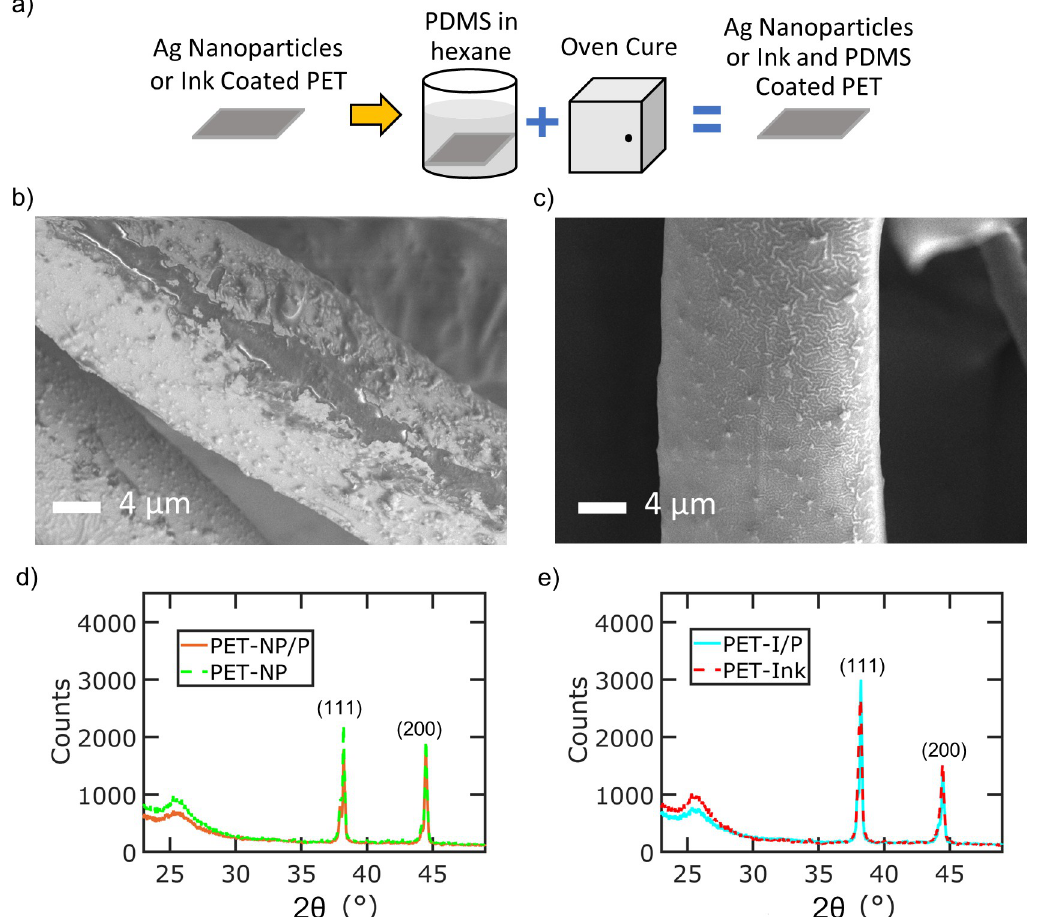
Fig 3. Characterization of samples with PDMS. a) Schematic of PDMS treatment for silver coated PET samples (b-c) SEM images of treated fiber of b) PET-NP/P and c) PET-I/P samples. d-e) XRD patterns of fabric samples before and after PDMS coating for d) PET-NP/P with PET-NP and e) PET-I/P with PET-Ink samples.